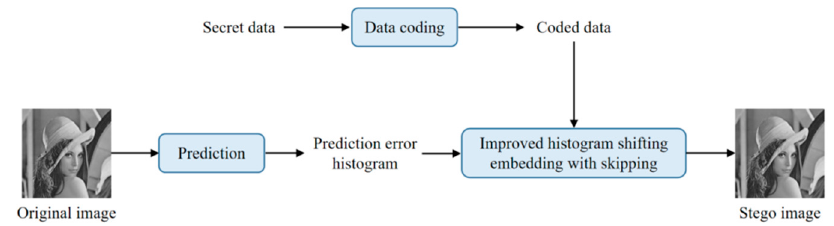
Figure 4. The data-hiding process.